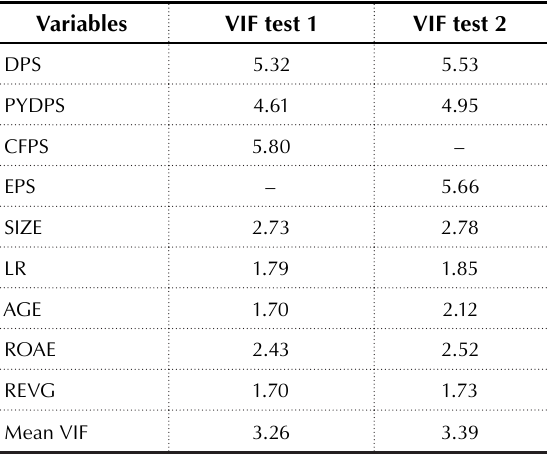
Table 4. Results of the Variance Inflation Factor (VIF)